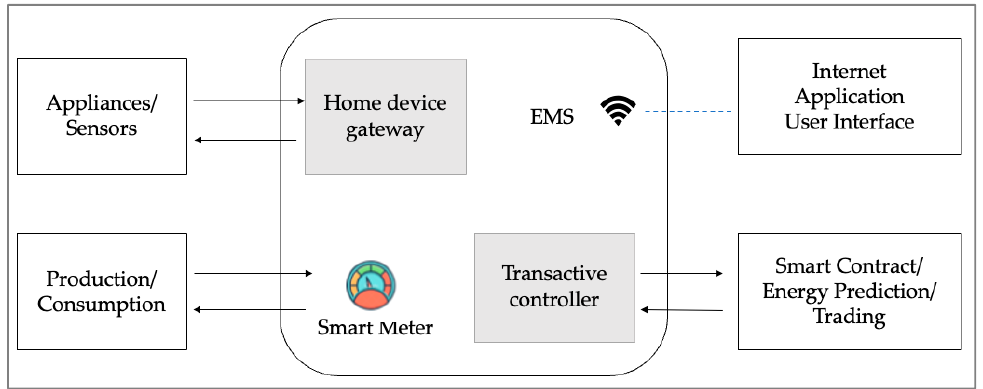
Figure 6. Energy management system architecture.